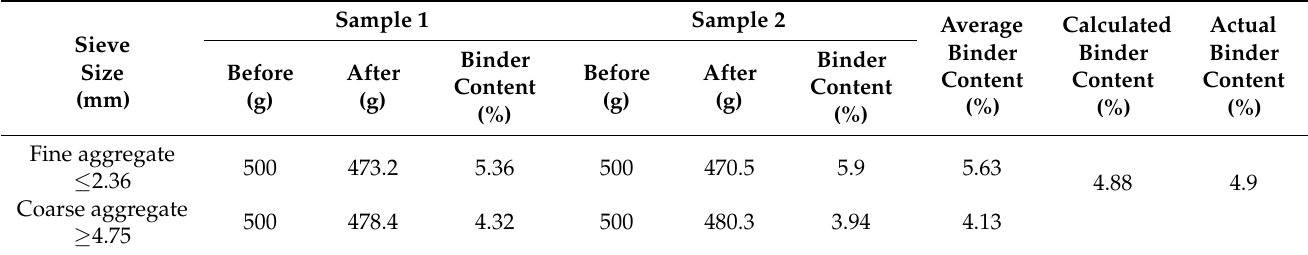
Table 8. Asphalt binder content of the RAP.